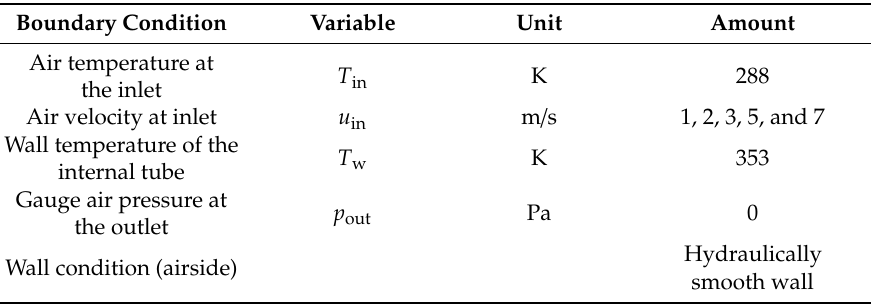
Table 2. Boundary conditions of numerical